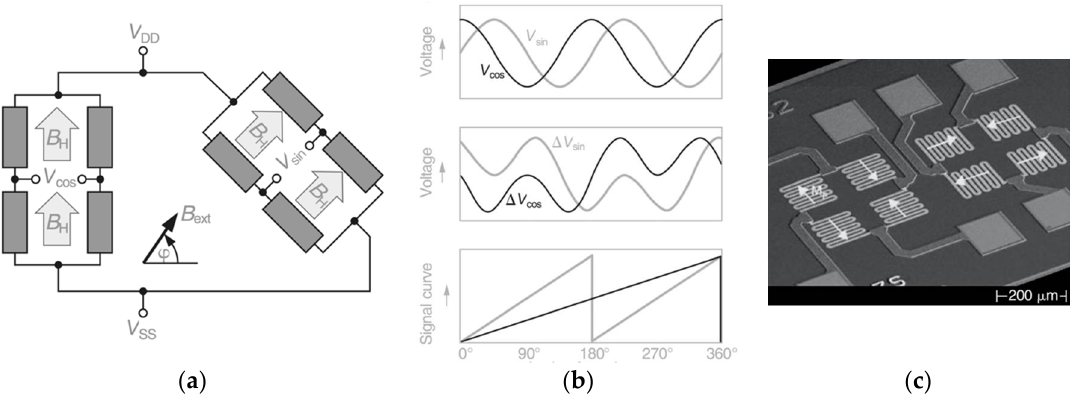
Figure 9. AMR sensor principle. ( a ) Sensor bridge circuit, where B H is the control induction, U sin and U cos are the measurement voltages, U DD and U SS are the supply voltages and B ext is the external magnetic field with the angle of rotation φ of the magnet; ( b ) Resulting sensor signals; ( c ) Electro microscopical exposure of a 360° AMR sensor layout, reproduced from [9]. Copyright 2007, Robert Bosch GmbH.